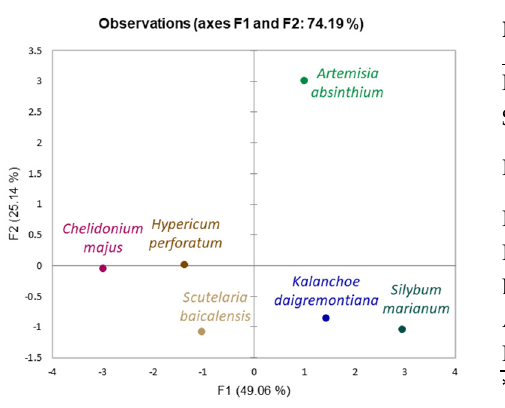
Figure 2. Principal component analysis (PCA) scatterplots indicating distinct differences in medicinal plant-derived nanoparticle characteristics and corresponding factor loadings.